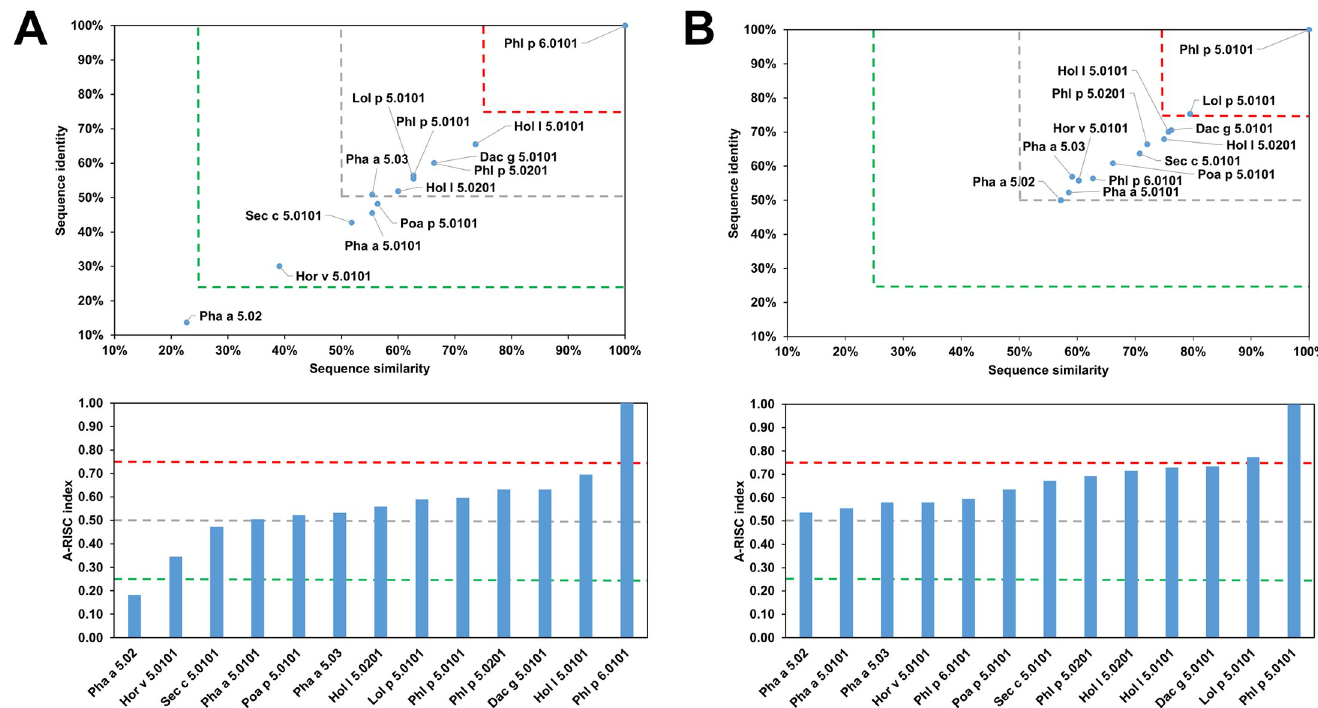
Fig 18. Plots showing relative homology and A-RISC indexes of allergens from Group V/VI grass pollen family. Comparison of family members to Phl p 6.0101 (A) and Phl p 5.0101 (B). Red, gray and dark green dashed lines indicate respectively 75%, 50% and 25% sequence identity and similarity, or 0.75, 0.50 and 0.25 A-RISC